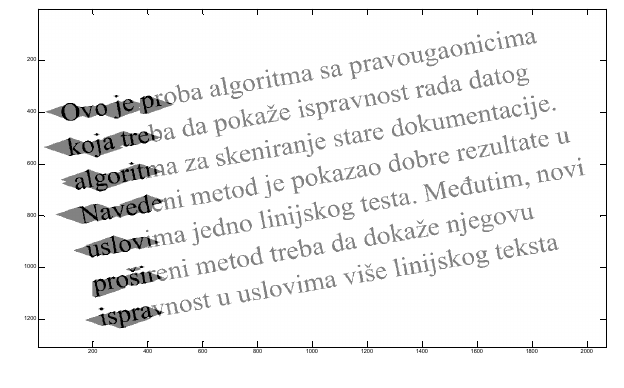
Figure 9. Water flow algorithm applied to the text sample.